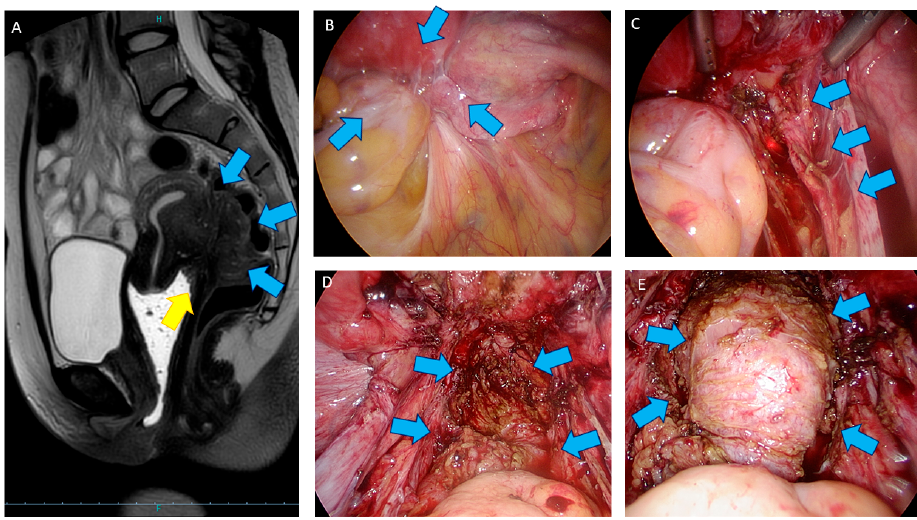
Figure 5. ( A ) Pelvic MRI with a T2-weighted sagittal view of a DE nodule (blue arrow) invading the anterior rectosigmoid junction. The nodule also infiltrate the posterior upper vagina (yellow arrow). ( B ) Laparoscopic view of the Douglas pouch obliterated by DE nodule (blue arrow). The uterus, rectum, right adnexa, and right ureter are fixed together. ( C ) Laparoscopic view of the right ureter after ureterolysis (blue arrows). ( D ) Laparoscopic view of the rectum after shaving. Fibrotic tissue (blue arrow) can stay after shaving and does not evolve. ( E ) At the end of procedure, additional procedures (blue dye test, blue arrow) are be performed to ensure rectal integrity.